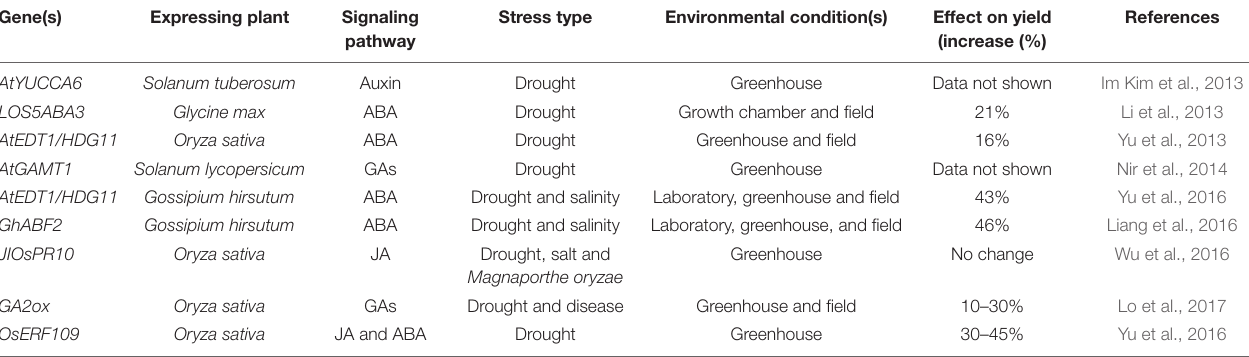
TABLE 1 | Transgenic crops under drought stress experienced altered yields through the phytohormone signaling pathway.